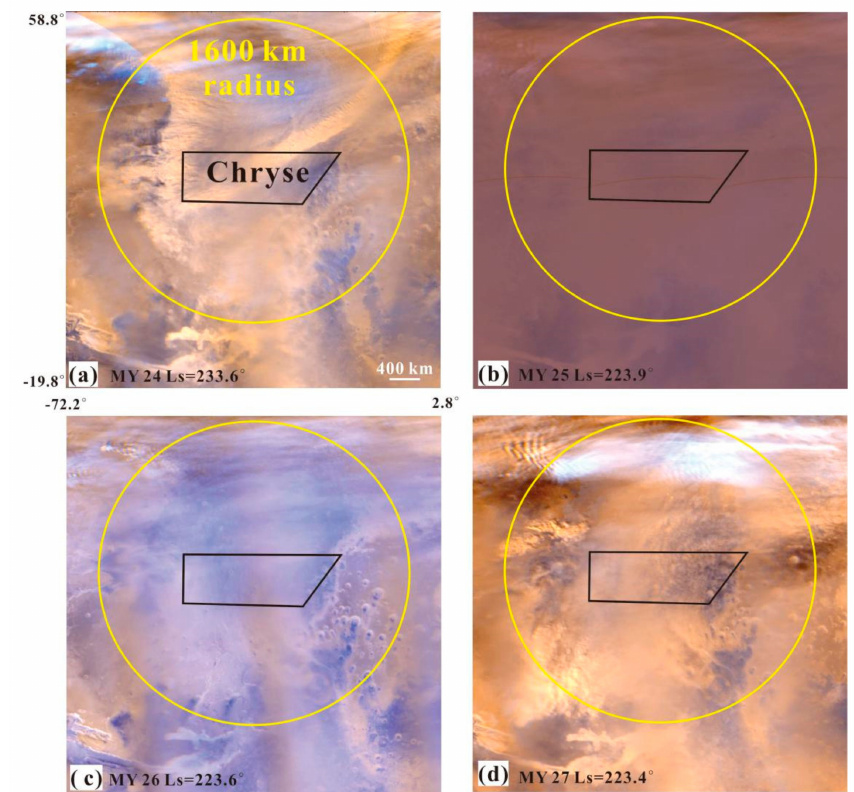
Figure 4. The MOC MDGMs at Ls = 223 ◦ of the Chryse area in four Martian years. The black polygon and yellow circle are the Chryse and its 1600 km-radius monitoring ring, respectively. ( a ) is the MOC MDGM at Ls = 223.6 ◦ in MY 24. ( b ) is the MOC MDGM at Ls = 223.9 ◦ in MY 25 and shows the PEDE. ( c ) is the MOC MDGM at Ls = 223.6 ◦ in MY 26. ( d ) is the MOC MDGM at Ls = 223.4 ◦ in MY